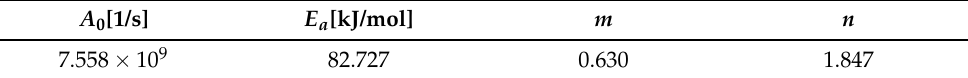
Table 2. Cure kinetics parameters (reproduced from [41] with the permission).